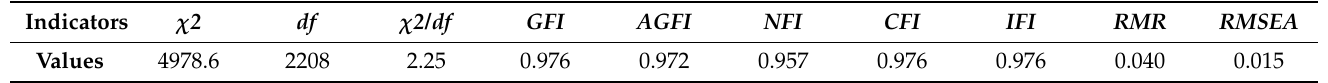
Table 1. CFA results ( n =